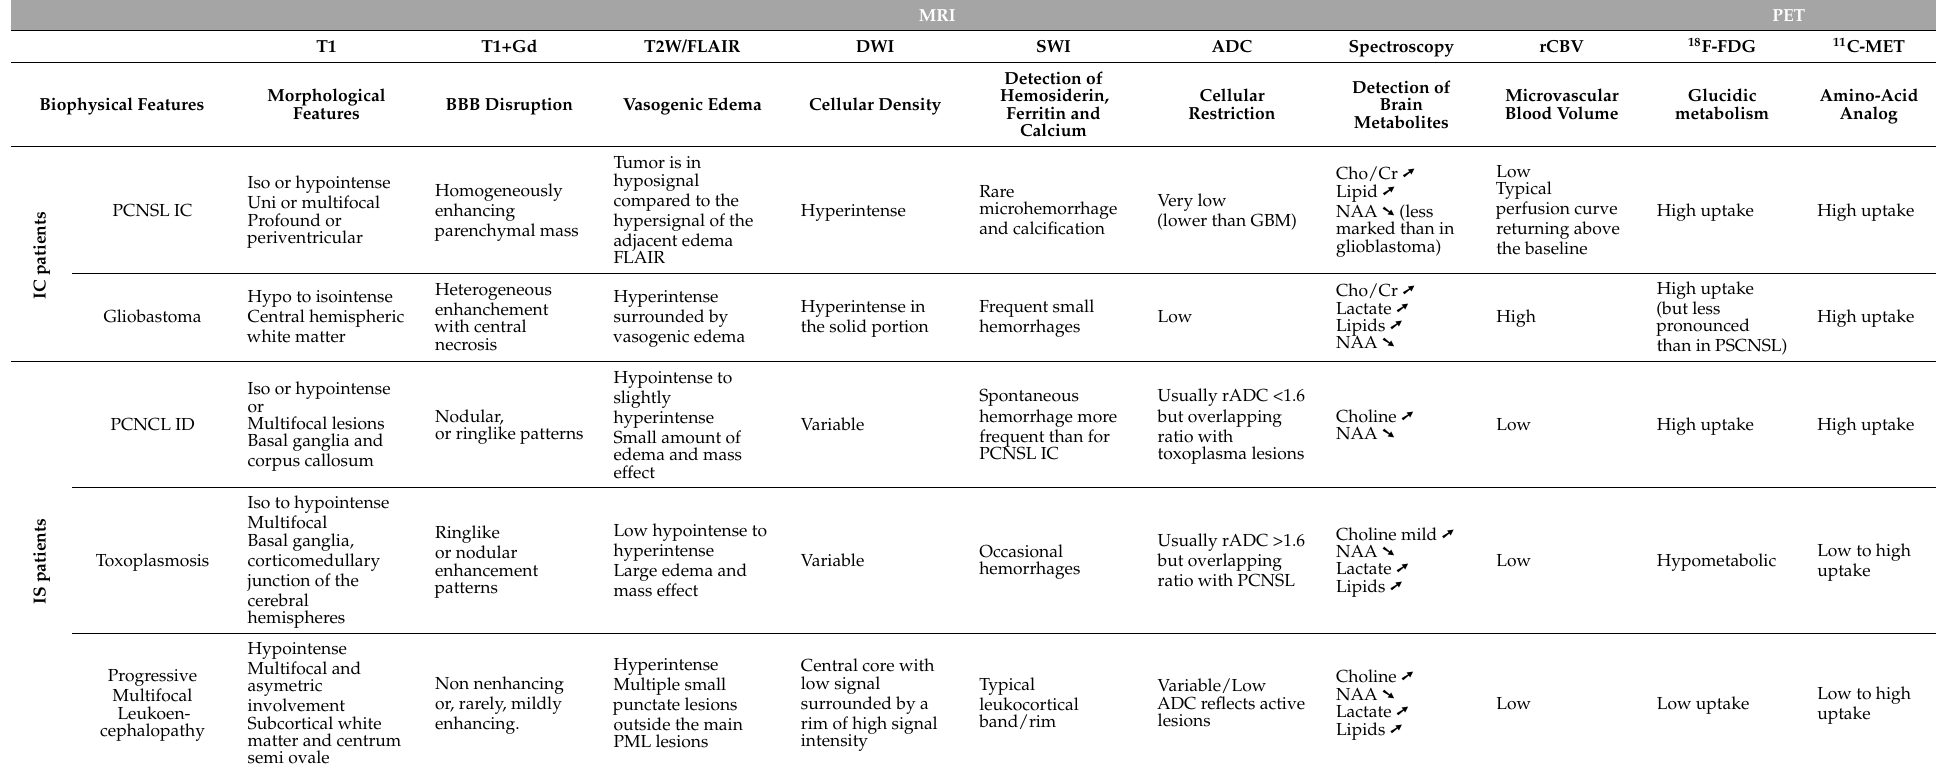
Table 1. MRI and PET characteristics of PCNSL and its main differential diagnoses [16,49–53]. MRI